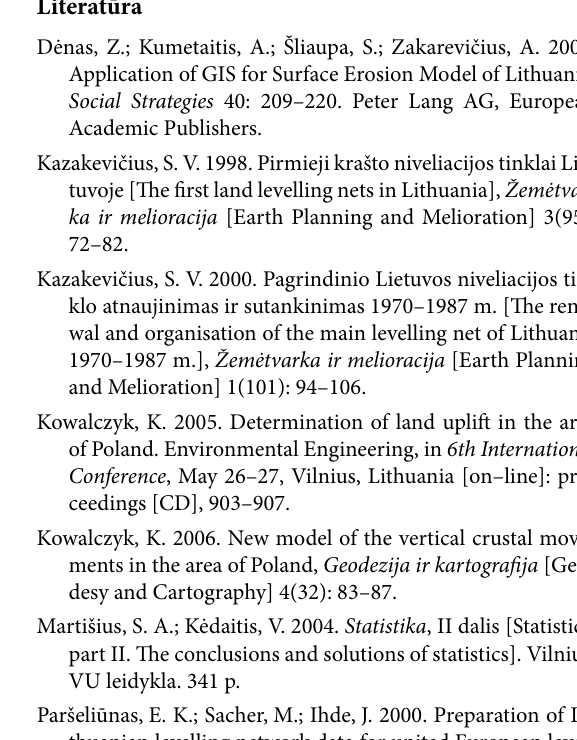
Fig. 5. Comparison of vertical Earth crust movements map with measured